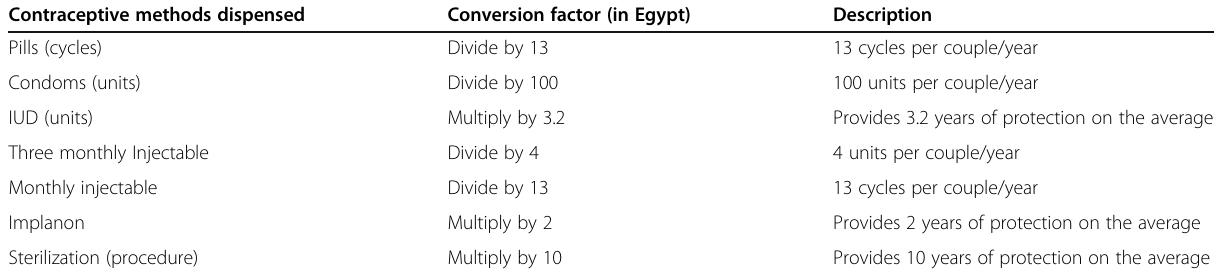
Table 1 Calculation of FP couple years of protection Contraceptive methods